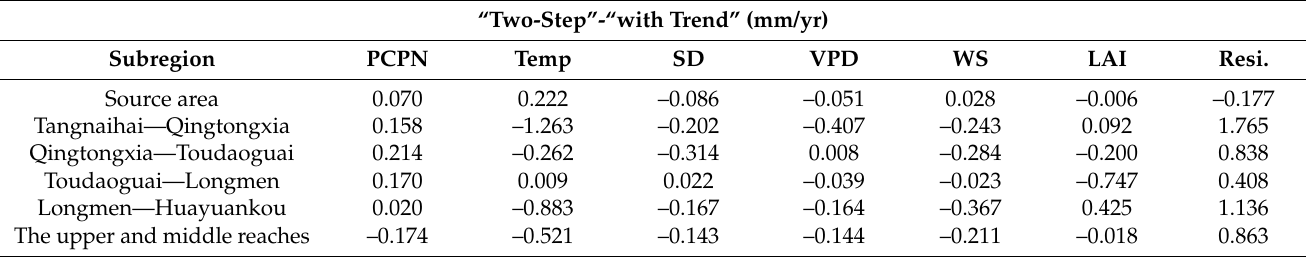
Figure 11. Spatial distributions of the sensitivity coefficients of the ET to the influencing factors calculated using two methods (“with trend” and “detrended”) and their differences with the “two- step” method. Table 4. The differences in the impacts of the climatic factors and the LAI on the ET trend calculated using three